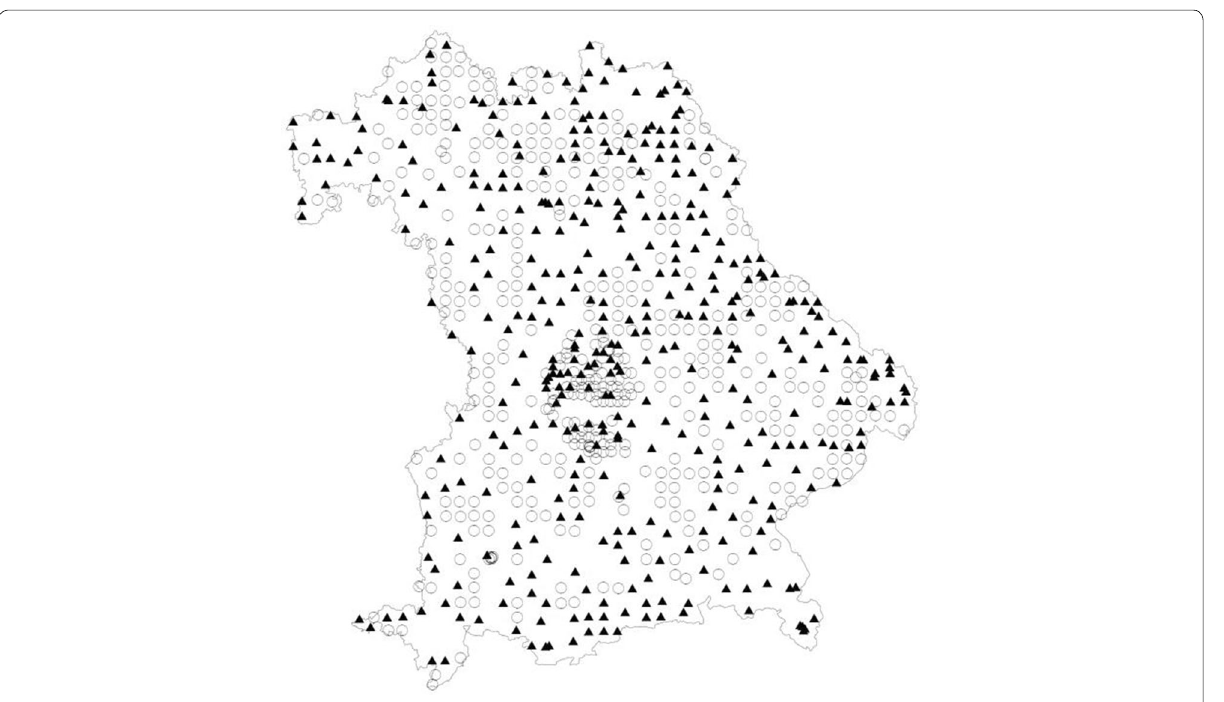
Fig. 2 Sampling sites (circle: agriculture; triangle: forest )